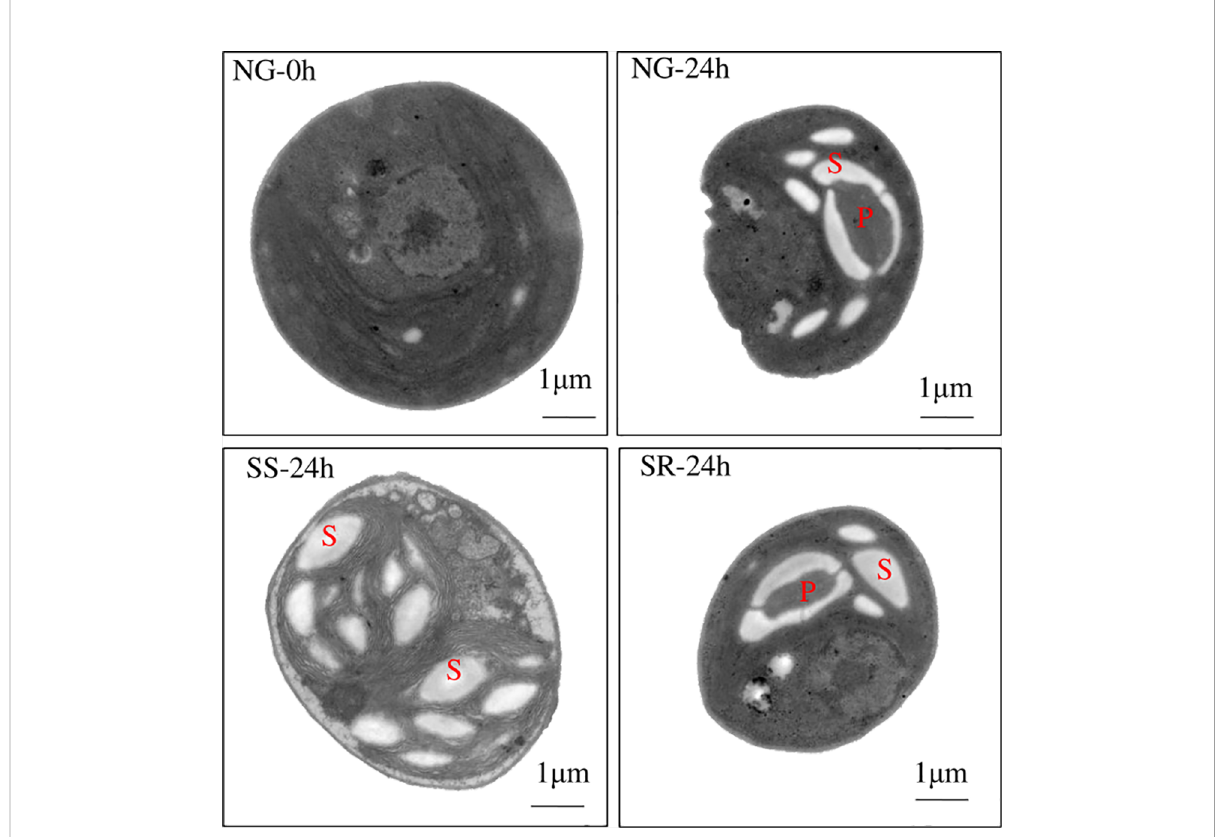
FIGURE 3 Cellular morphology of C. sorokiniana under different culture conditions observed using transmission electron microscopy. NG, normal growth; SS, sulfur starvation; SR, replenishment. P, pyrenoid; S, starch